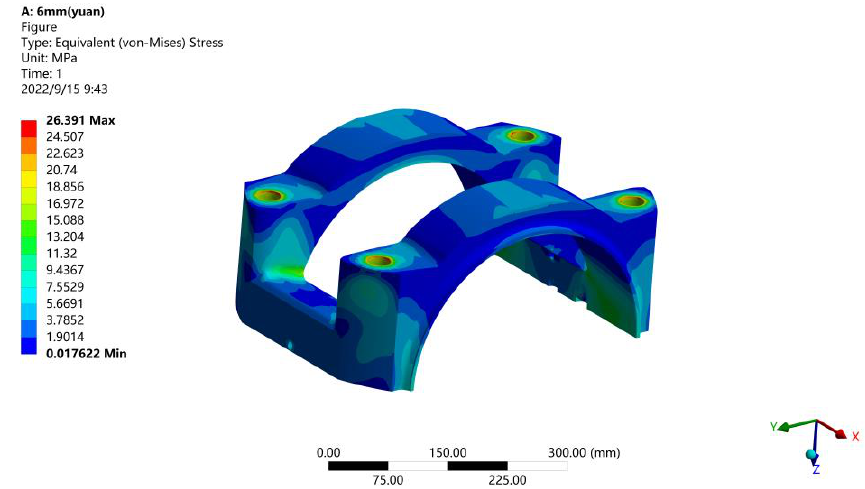
Figure 10. Stress diagram of small end bearing cover of connecting rod.